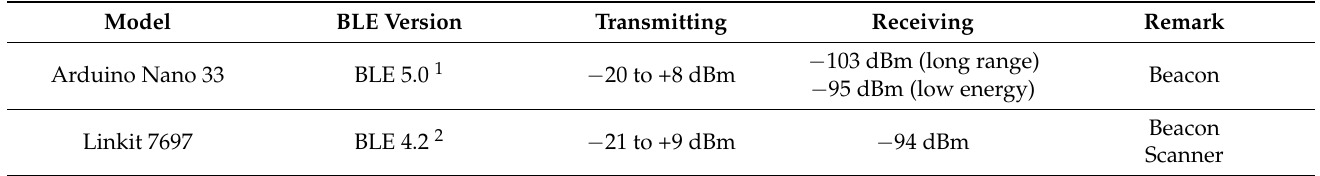
Table 2. Specifications of the components (BLE 5.0 and BLE